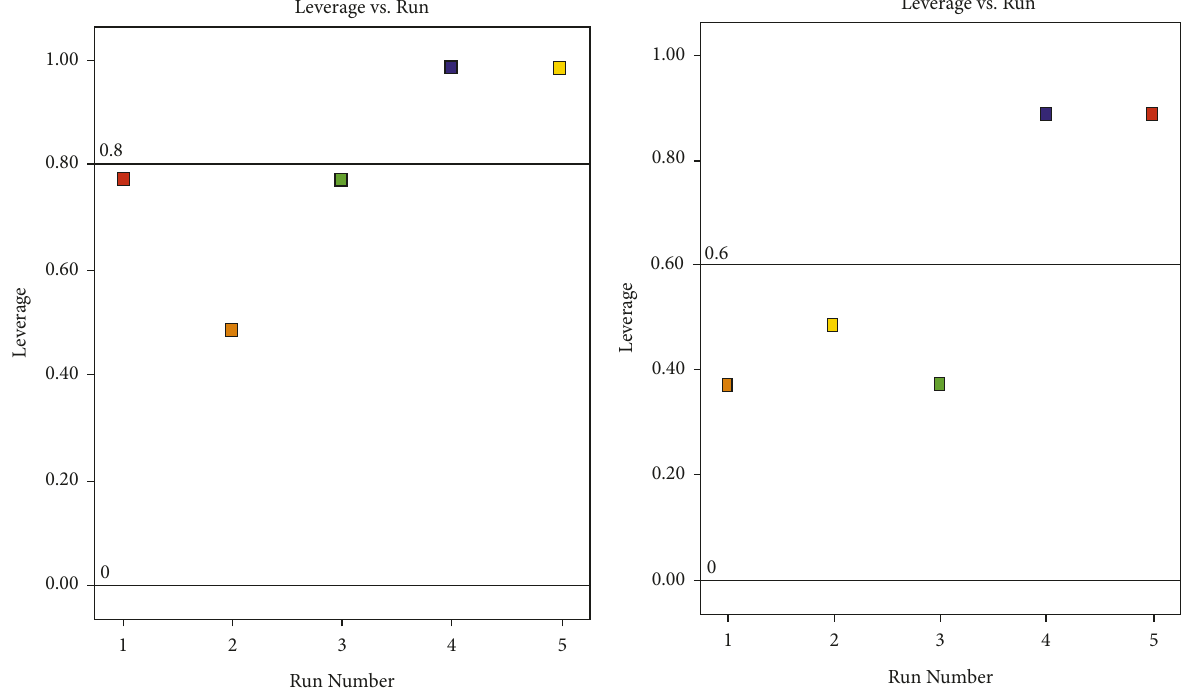
Figure 14: Leverage vs. run diagnostic influence